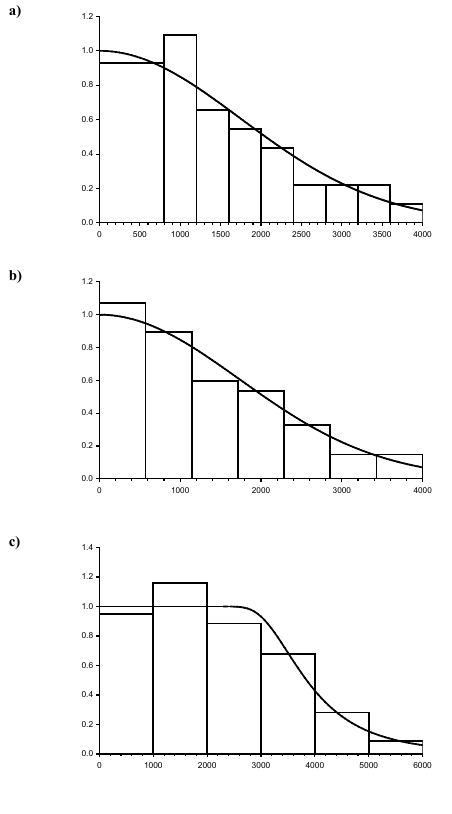
Fig. 2. Detection functions for line transect and cue count analyses of sperm whale abundance from NASS-2001 Icelandic and Faroese ship sur - veys. a) Iceland, line transect, at surface abeam; b) Iceland, line transect, all sightings; c) Iceland, cue